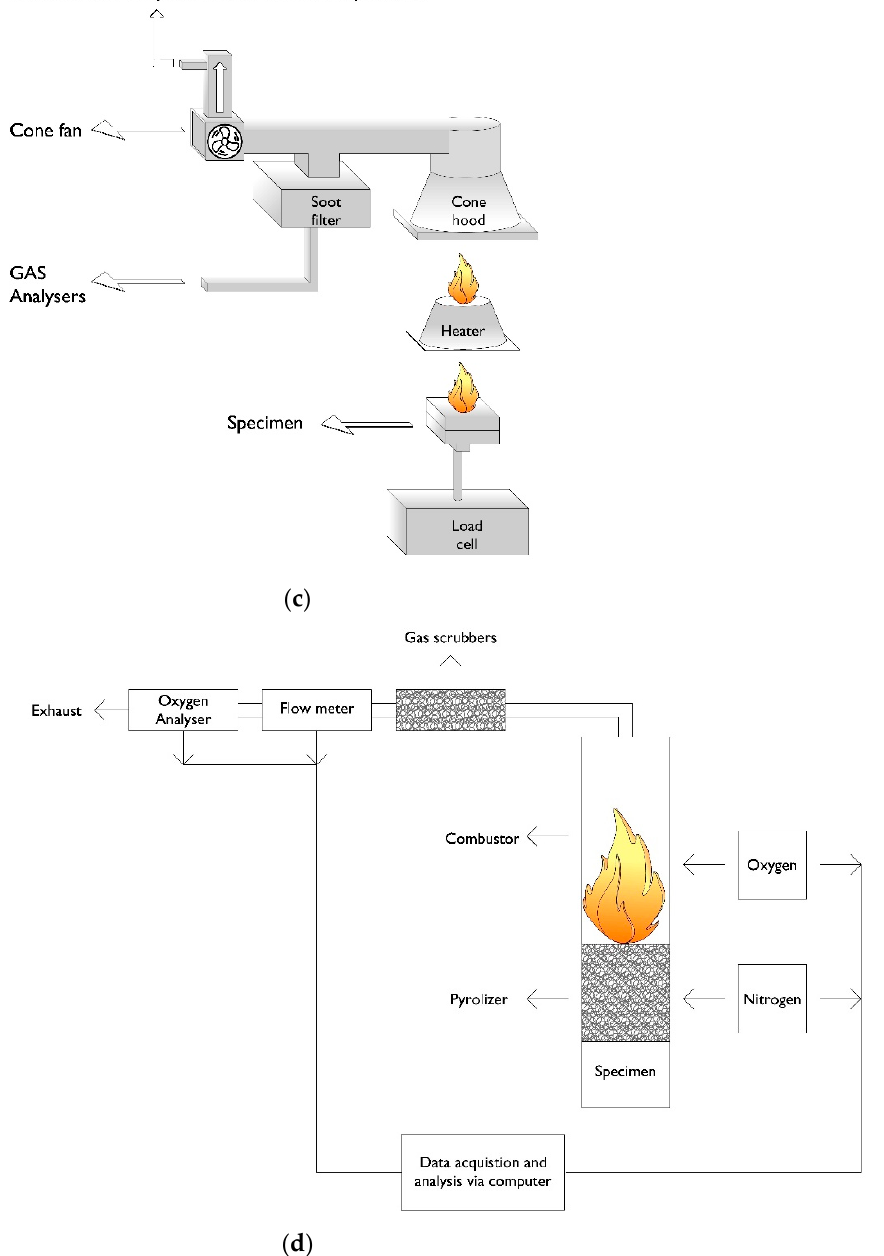
Figure 3. Different tests used to measure the effects of combustion inhibitors. Limiting oxygen index ( a ), vertical flammability ( b ), cone calorimeter ( c ), and pyrolysis-combustion flow calorimeter ( d ).